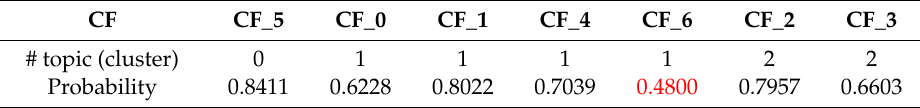
Table 3. Results of the Semantic Clustering of